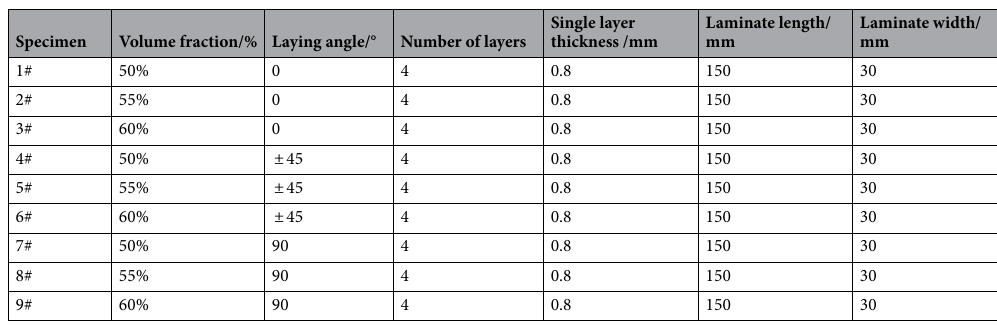
Table 1. Samples of composite laminates.